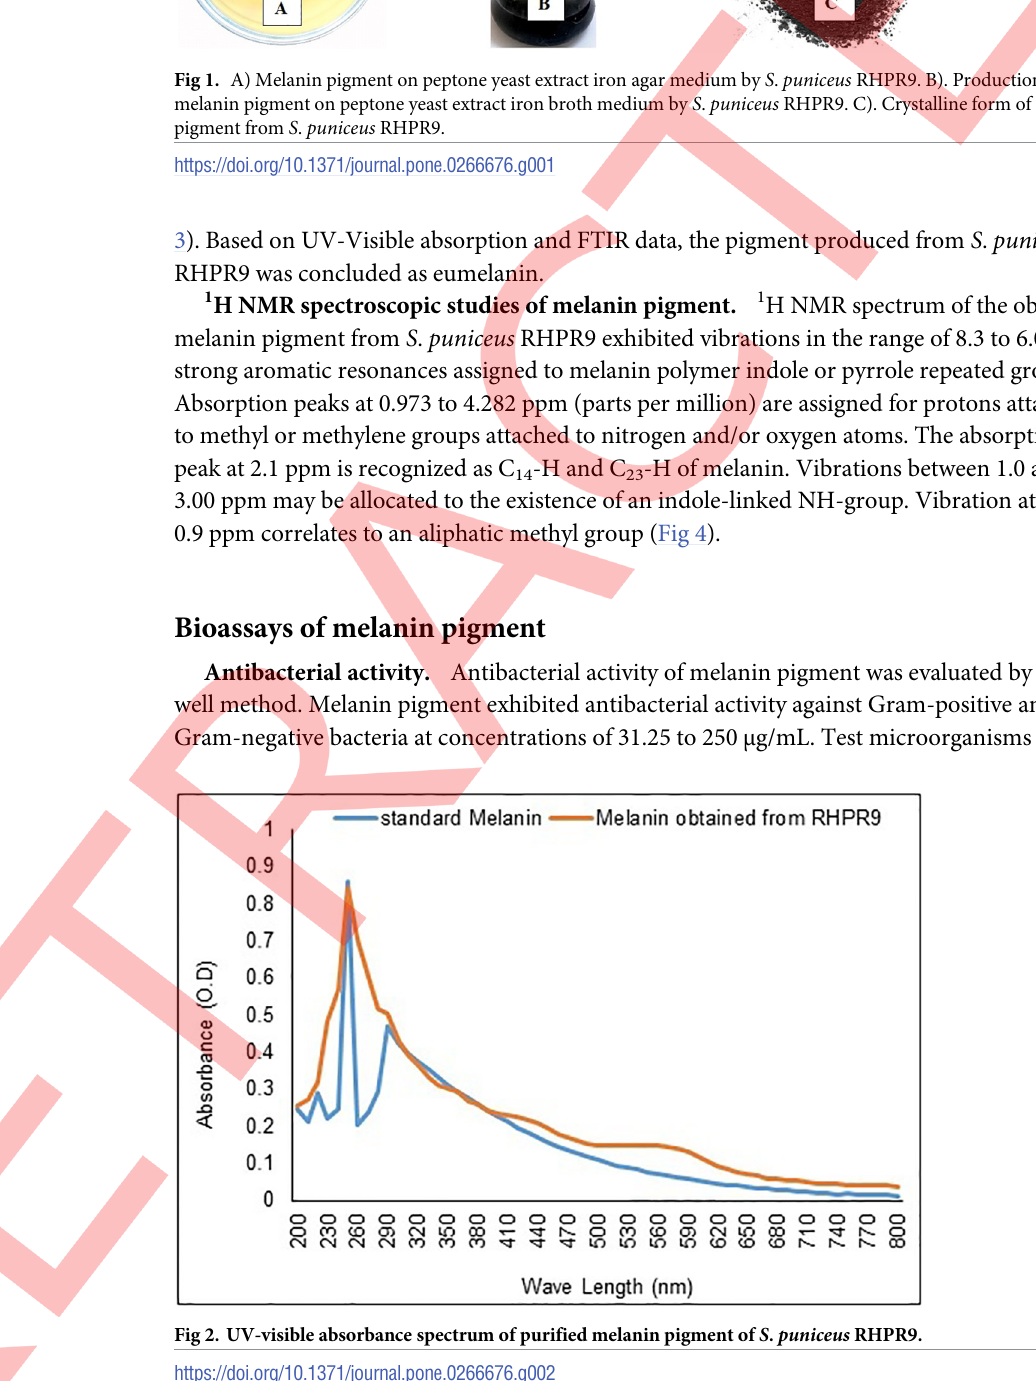
Fig 2. UV-visible absorbance spectrum of purified melanin pigment of S . puniceus